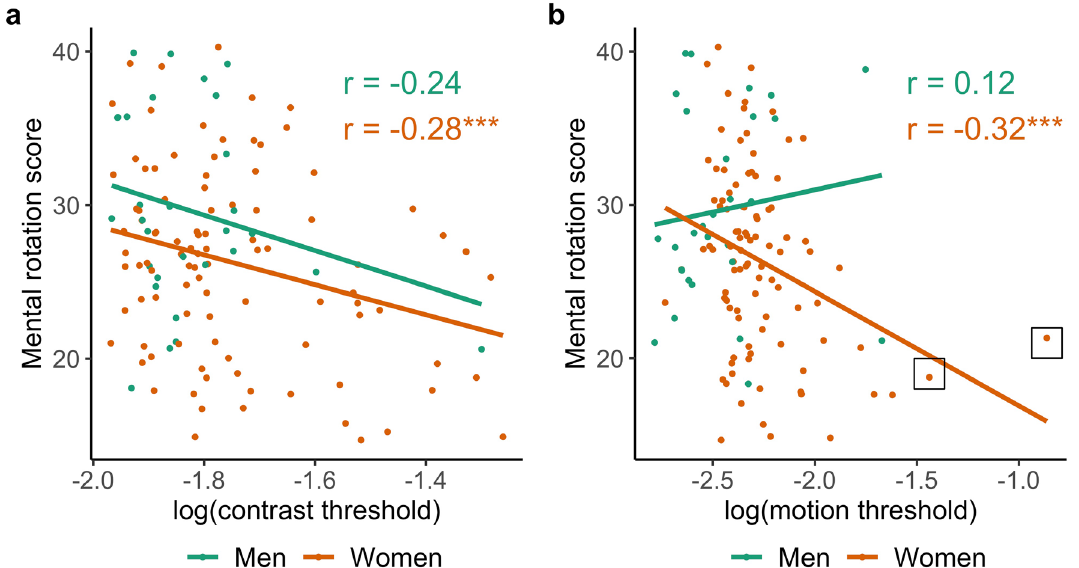
Figure 2. Associations between mental rotation scores and vision measures. Each point represents an individual participant’s mental rotation scores as a function of ( A ) log contrast thresholds and ( B ) log motion duration thresholds. Two female participants whose log motion duration thresholds exceeded 3 SD from the combined sample mean are indicated with squares. Larger thresholds reflect poorer performance. The figure shows that vision thresholds correlate with mental rotation scores, especially in women. Correlation significantly less than 0, ***p <